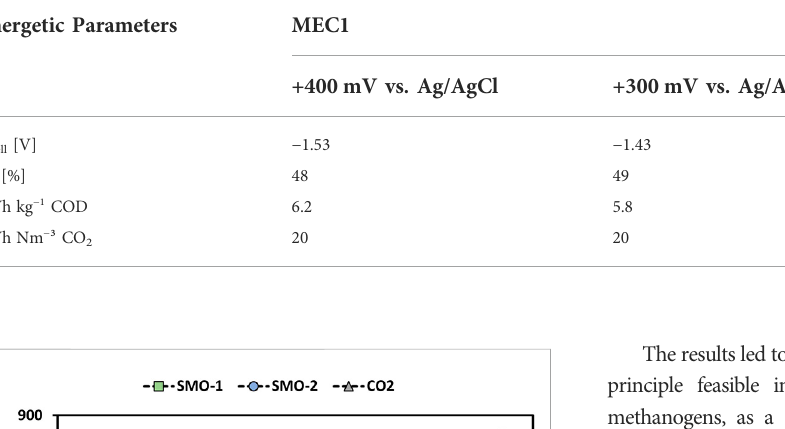
TABLE 4 Comparison of energetic parameters for all experimental conditions.